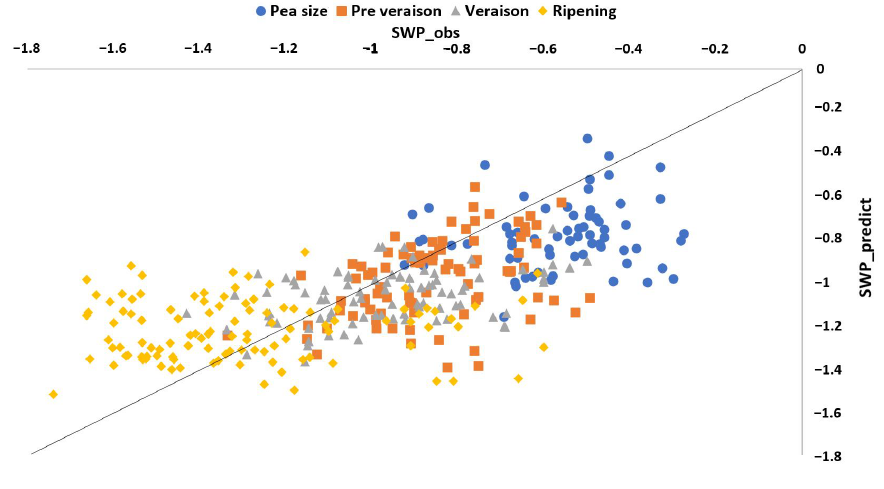
Figure 13. Data distribution according to development